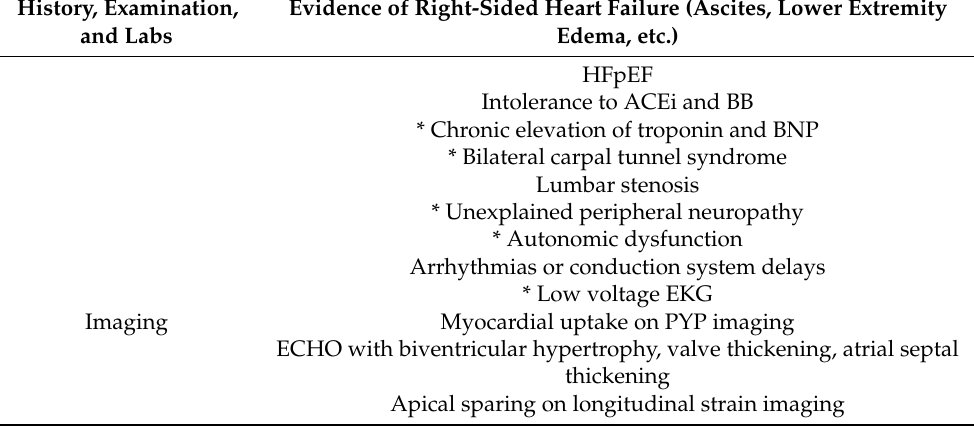
Table 3. Diagnostic clues of